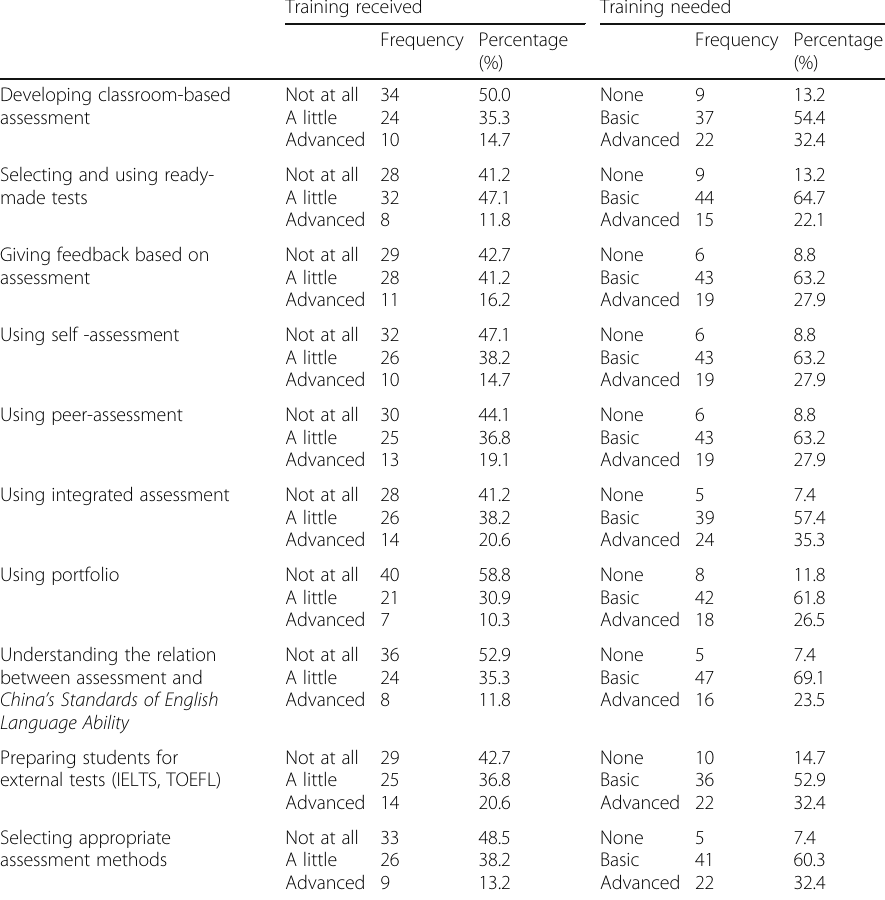
Table 4 Respondents ’ assessment training received and needed in classroom-based assessment practices